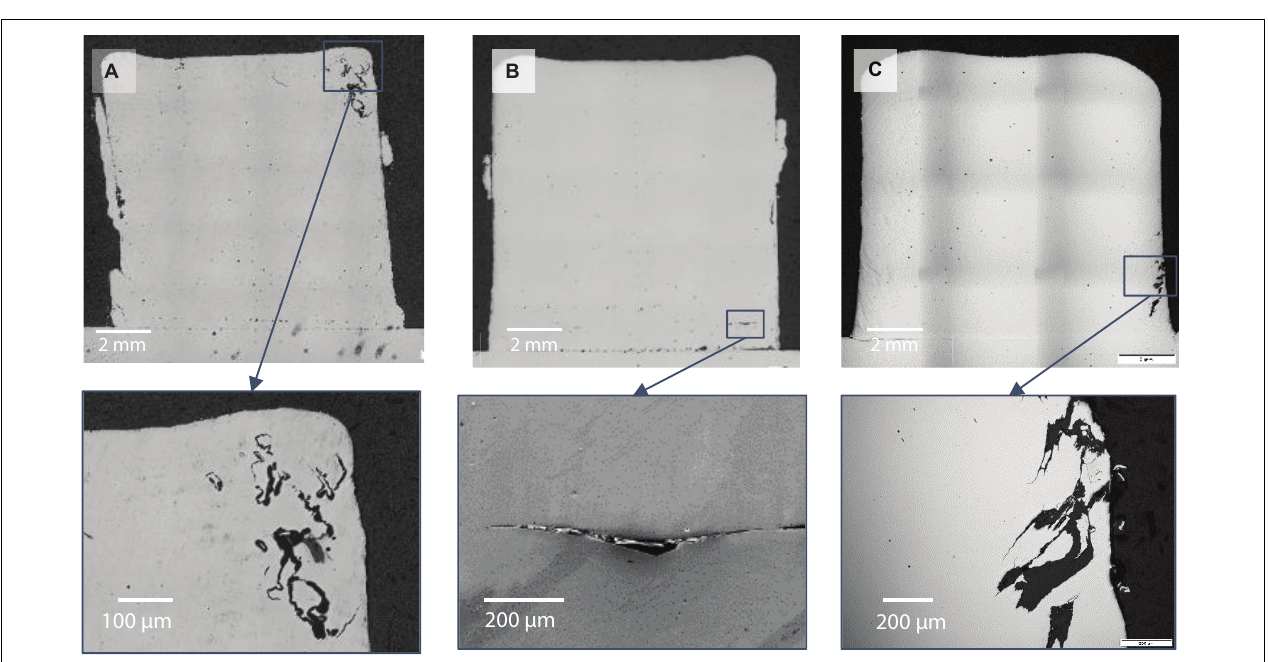
FIGURE 3 | Sample cross-sections of A samples with different pre-heating temperatures on the surface plate during build-up. Respectively at room temperature (RT; (A) ), 300 ◦ C (B) , and 450 ◦ C (C) , including relevant material defects in each case.